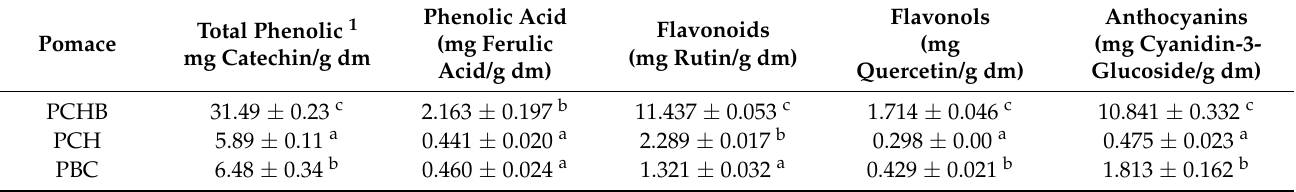
Table 2. Selected phenolic compounds content in fruit